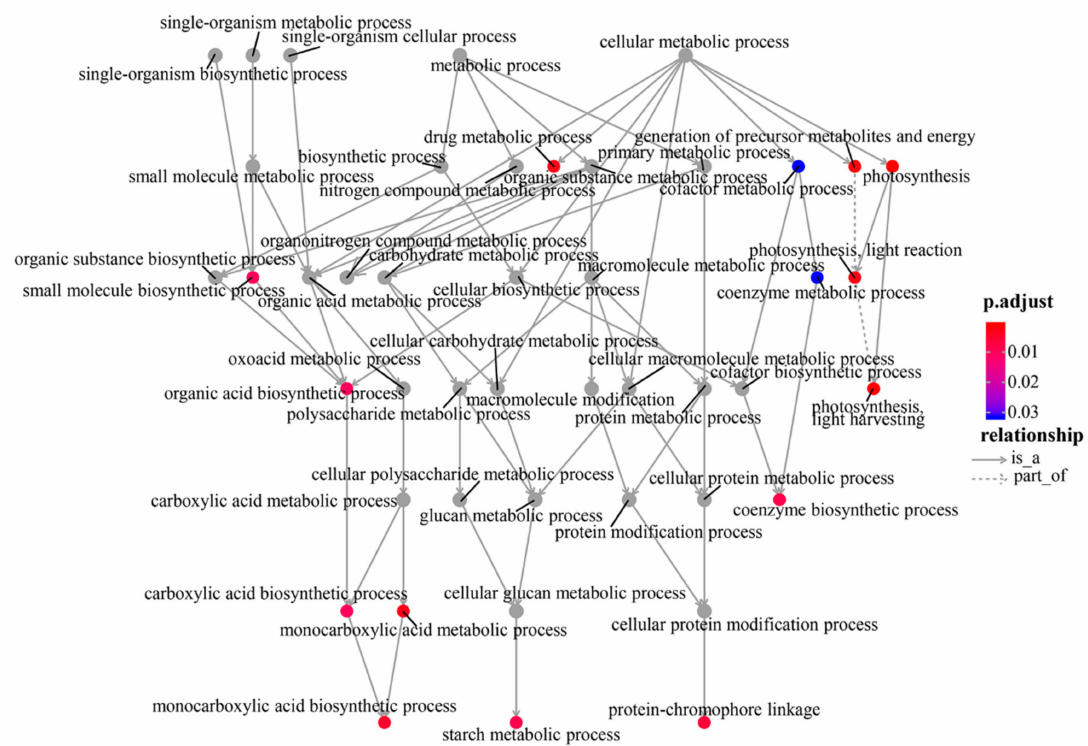
Figure 5. Gene and biological process connect network.